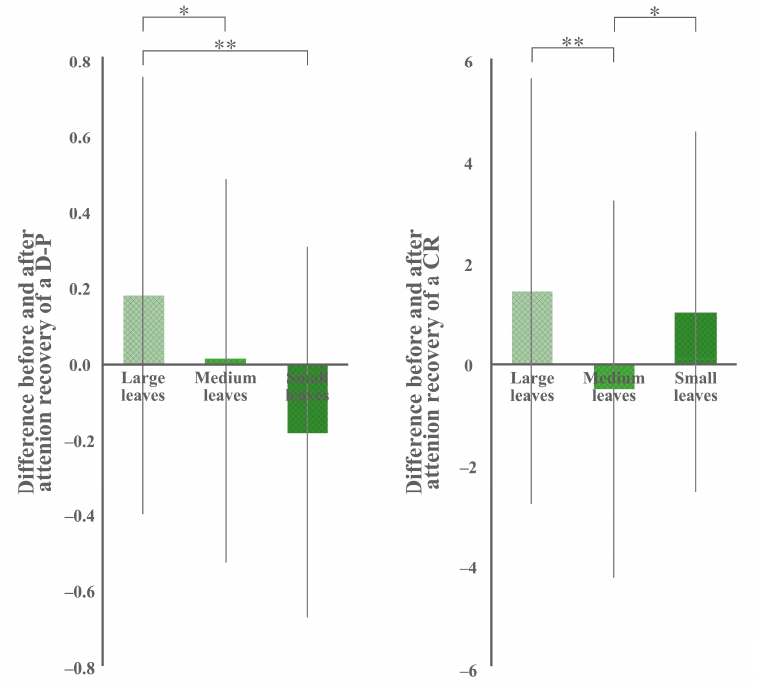
Figure 12. Main effect maps of the leaf size of indoor plants on attention recovery. ** Stands for statistical significance at the 0.01 level; * Stands for statistical significance at the 0.05 level; Not marked stands for no statistical significance.